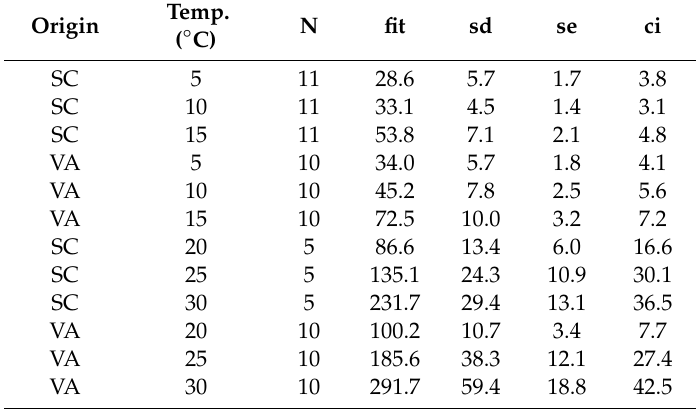
Table 2. Predicted SMR from linear mixed effect model. SC = southern population, VA = northern population. Fit = predicted SMR, sd = standard deviation, se = standard error, ci = 95% confidence interval. Origin Temp. (°C) N fit sd SC